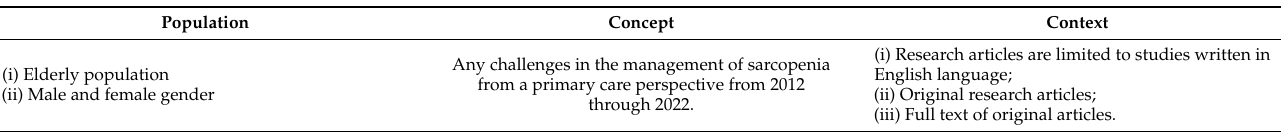
Table 1. Inclusion